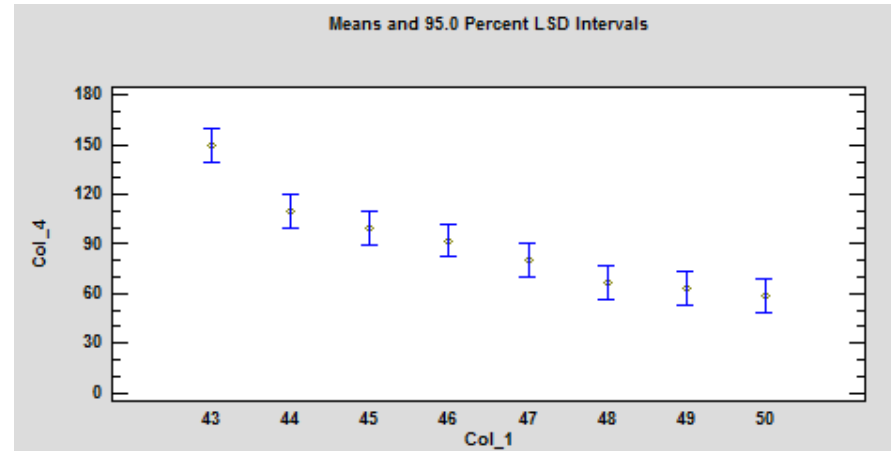
Figure 6. Graphical representation of the statistical evaluation of the influence of heat flux on ignition time under the action of a radiant heat source on the OSB. Legend: Col_1, heat flux; Col_4, Time-to-ignition.